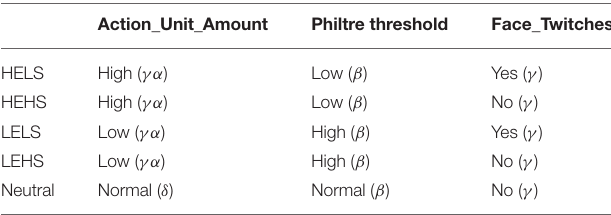
TABLE 2 | Based on the personality category of the agent, the amount for activated action units is